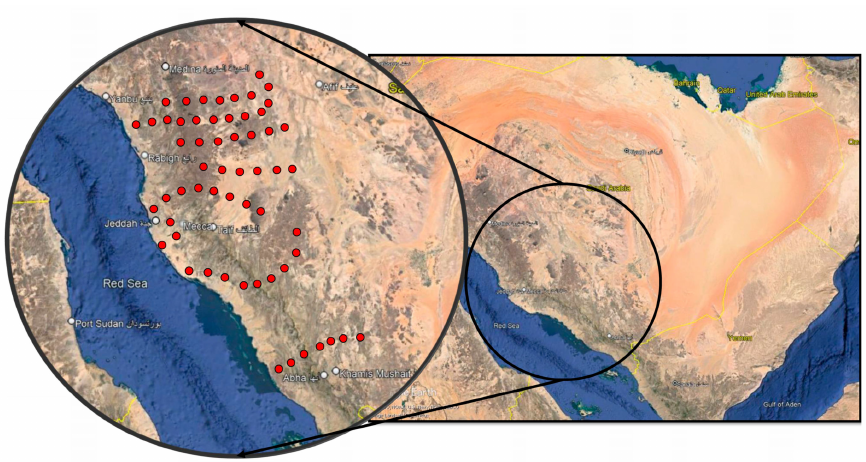
Figure 1. A map of Saudi Arabia with a focus on the study area (the circle on the left) showing the selected sampling stands (the red